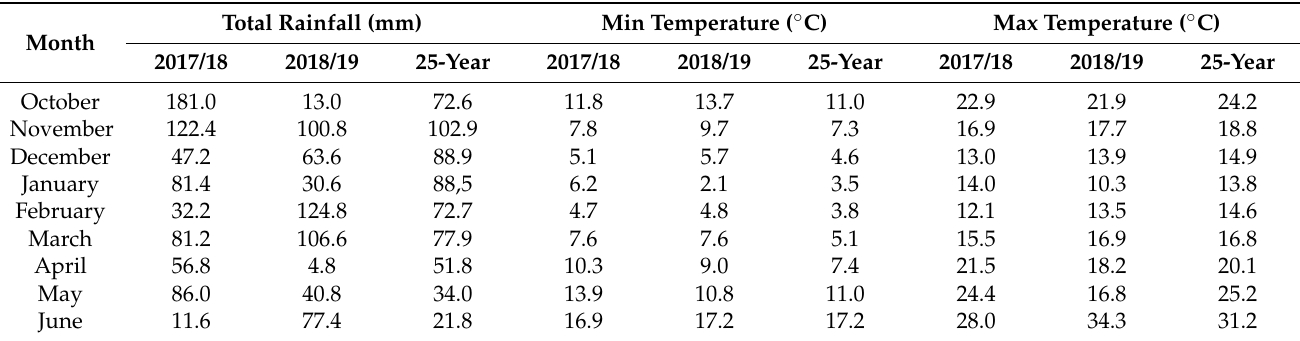
Table 2. Monthly total rainfall and air temperature means (maximum and minimum) during the two growing seasons and long-term average (1994–2019). Total Rainfall